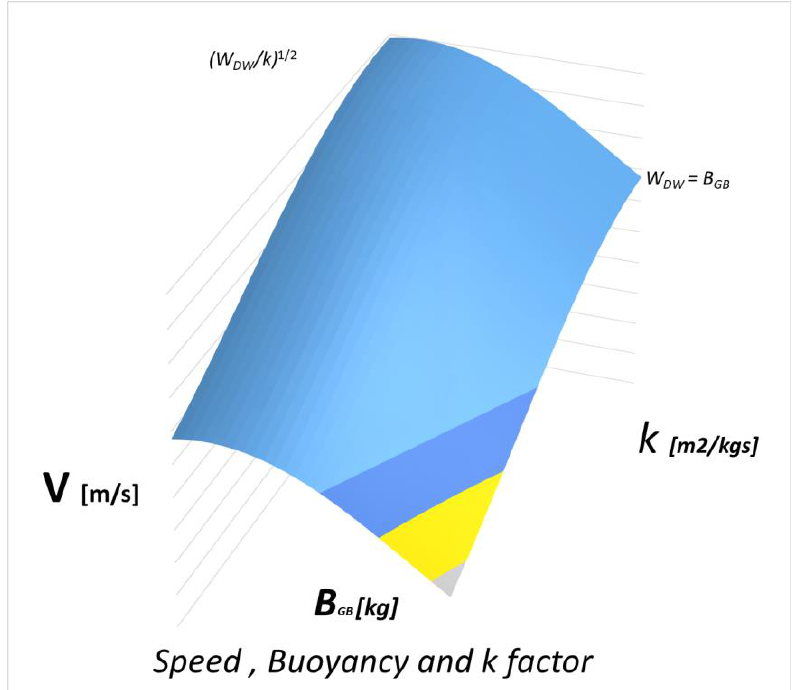
Figure 9. Qualitative trend of the function speed, drone buoyancy and k factor.